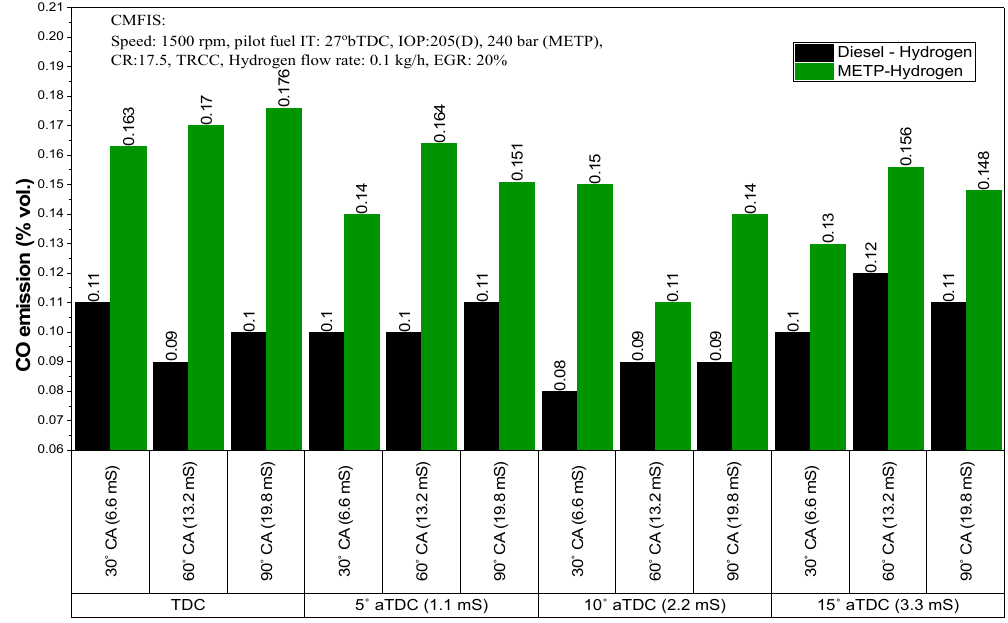
Start of injection and injection duration of Hydrogen (Manifold injection) Figure 13. Carbon Monoxide (CO) for manifold injection of Hydrogen in CMFIS based a dual-fuel engine.